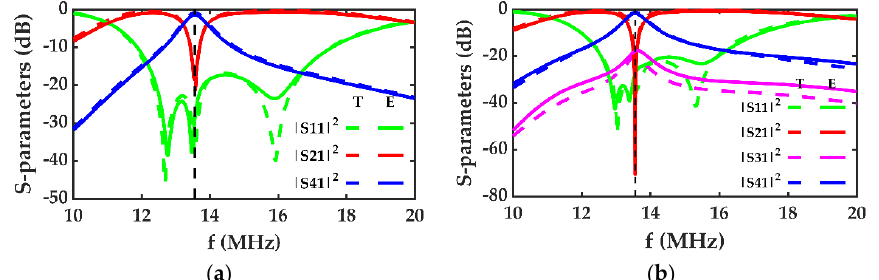
Figure 7. Experimental (solid) and theoretical (dashed) frequency dependence of scattering parameters for MI filter with resistive narrowband terminations (2) with ω 0 = 13.56 MHz, Q = 200 , and 𝑍 0𝑀 = 50Ω . ( a ) κ c = 0.28 and 𝜆 = 1 ; ( b ) infinite rejection with κ c = 0.25 and 𝜆 = 0.79.